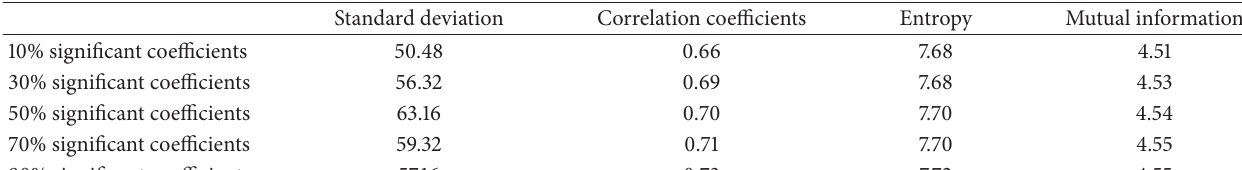
Table 2: Indexes of performance evaluation.